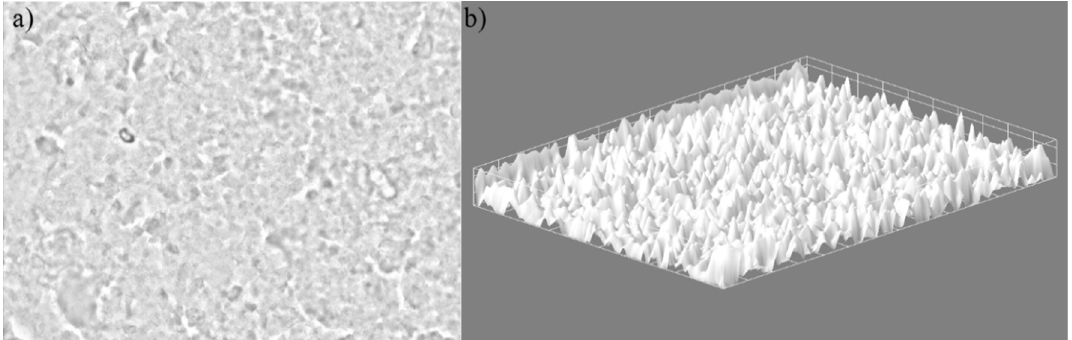
Figure 13. Optical microscopy image of the 25MgHAp surface coatings ( a ) and 3D representation of the surface of the 25MgHAp coatings ( b ).